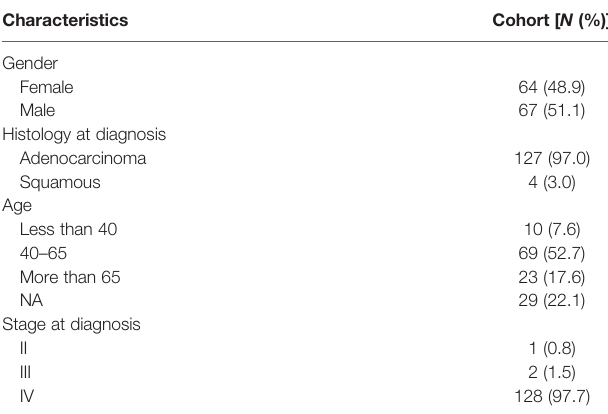
TABLE 1 | Clinical characteristics of